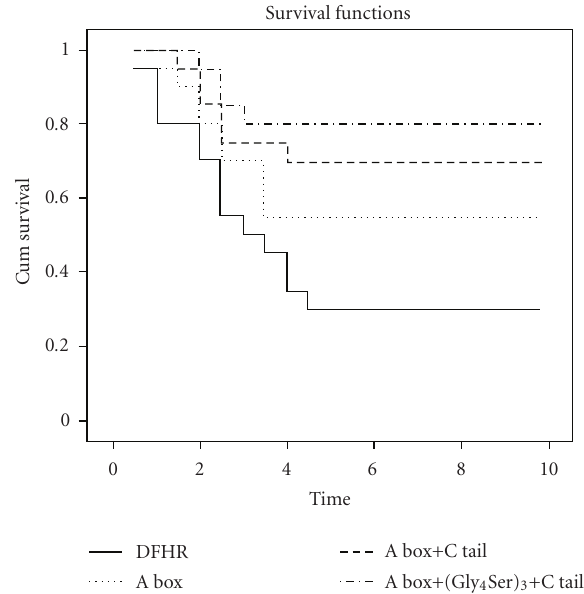
Figure 4: The C tail-fused A box could more e ff ectively protect against endotoxin lethality. BALB/c mice (20 mice/group), sub- jected to LD 75 doses of LPS, were treated at 0 and 12 hours after LPS administration with A box, A box+C tail, A box+(Gly 4 Ser) 3 +C tail, or DHFR control proteins (40nmol/mouse i.p. ). Mortality was monitored for up to 10 days. The survival rates were analyzed by the Kaplan-Meier method with comparisons between di ff erent groups. The results showed that the A box alone and the two C tail-fused A box proteins could significantly prolong life time and improve the survival rates of the mice ( P < . 05). The A box+(Gly 4 Ser) 3 +C tail protein had the most protective e ff ect, followed by A box+C tail and A box ( P < .